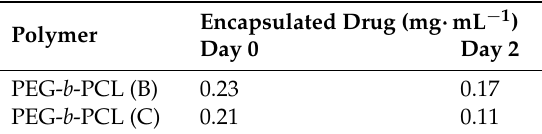
HPLC derived measurements of encapsulated drug immediately after producing drug-loaded micelles (Day 0) and 48 h after producing micelles (Day 2) from the membrane device. The fluconazole content in the organic phase was 0.4 mg ¨ mL ´ 1 per 1 mg ¨ mL ´ 1 PEG- b -PCL (B) or PEG- b -PCL (C),